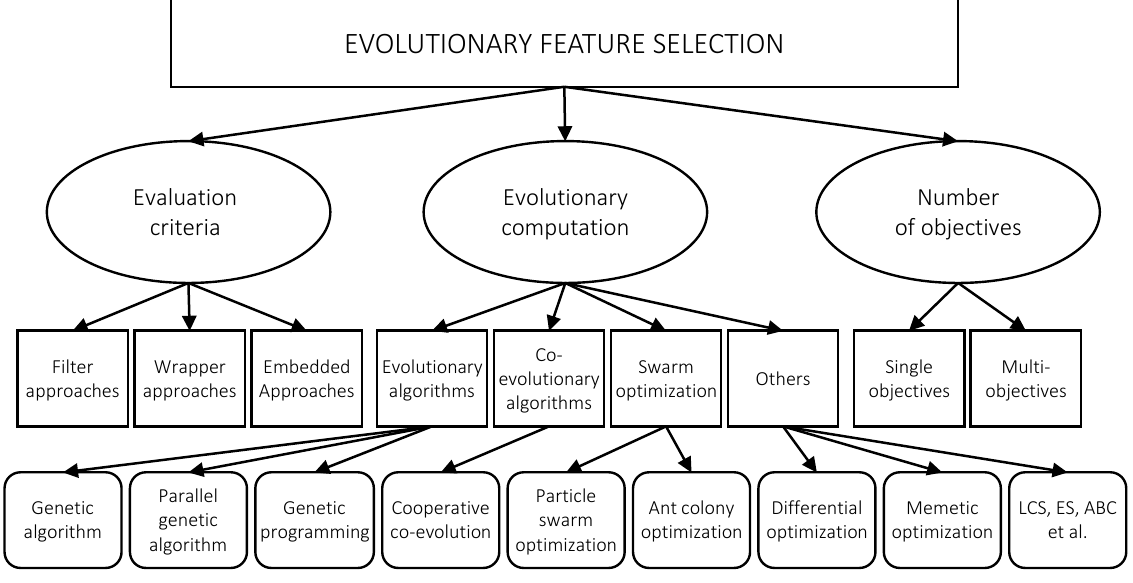
Figure 2. Overall categories of evolutionary computation for feature